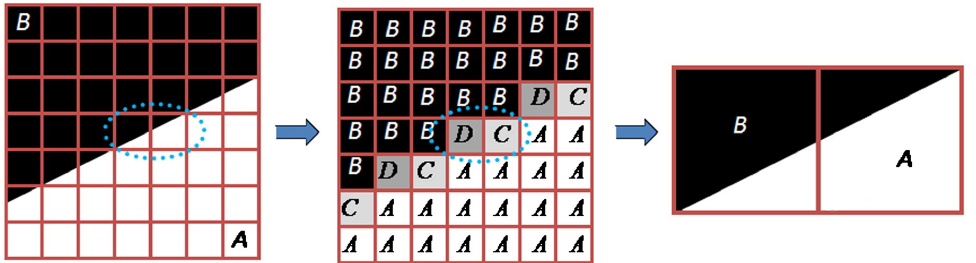
Figure 11. Underlying concept for estimating the edge at the subpixel level from the partial area effect [48]. Edge pixels are considered to have a weighted average intensity. Here, the pixel with value D has more weightage of pixel intensity B compared to pixel intensity A . Similarly, the pixels with intensity value C have a larger weightage of A compared to B . From these intensity values, subpixel edge locations are